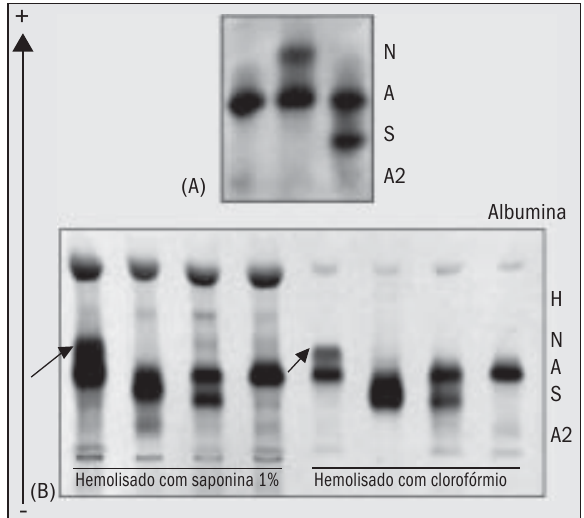
Figura – Migração eletroforética de amostras de sangue em acetato de celulose (A) e gel de agarose Celm (B) em pH alcalino, evidenciando a presença de hemoglobina N em heterozigose